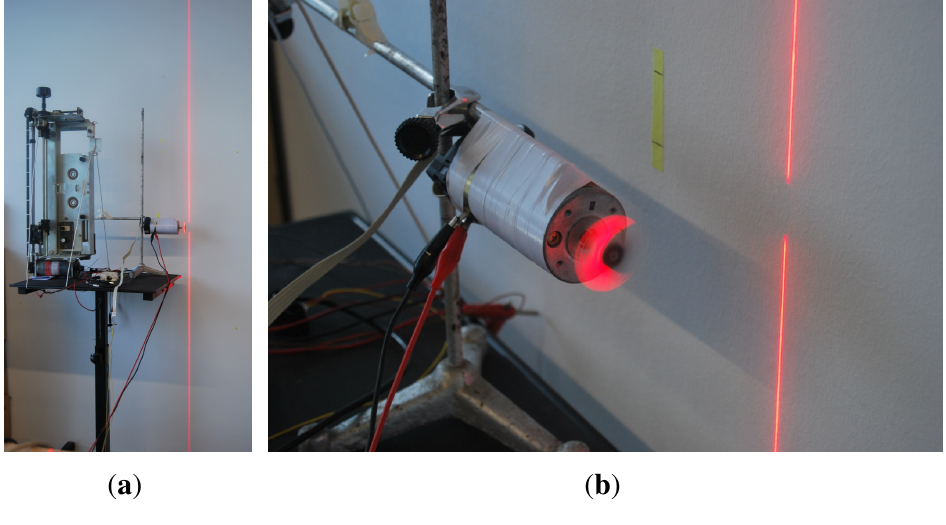
Figure 6. Laser beam projection into the helix. ( a ) Laser beam projection; ( b ) Detail of the moving helix.